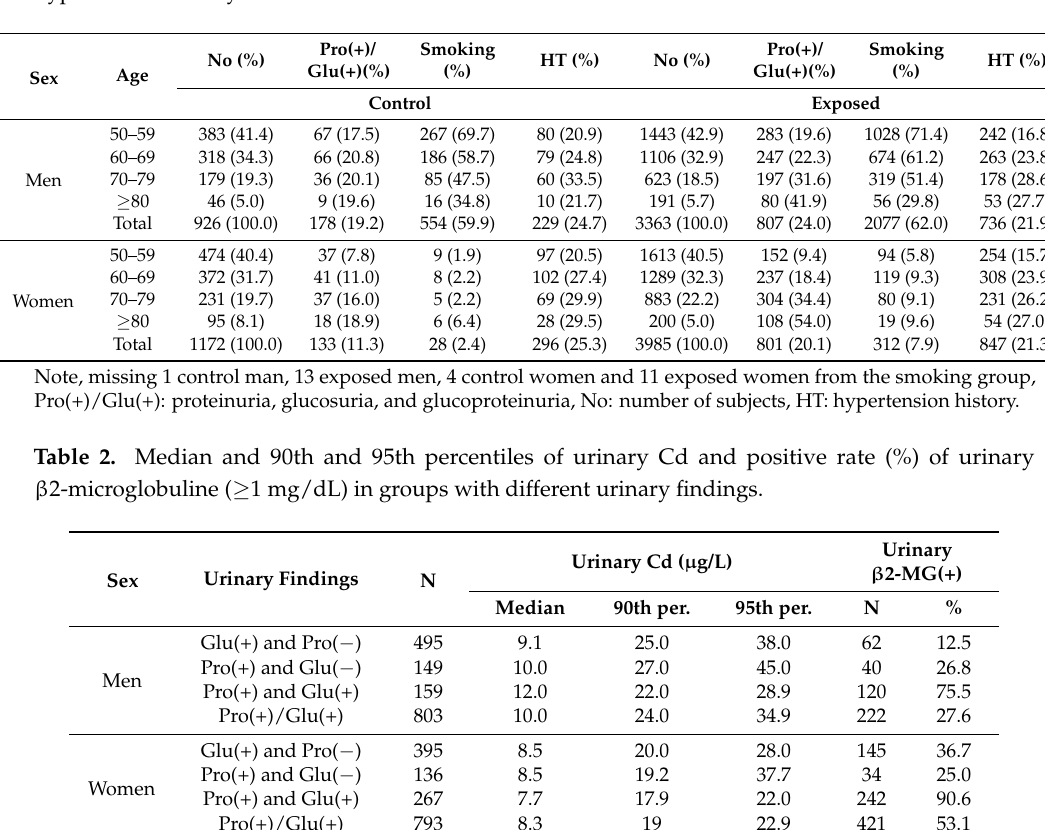
Table 1. Age distribution of prevalence of urinary findings: positive cases, smokers and cases with a hypertensive history.